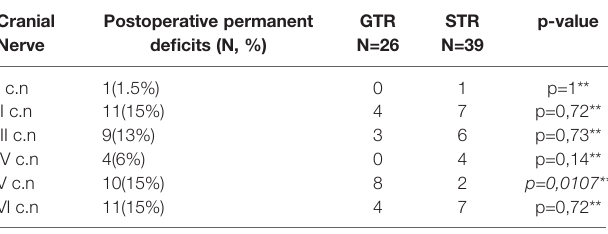
TABLE 3 | Postoperative cranial nerve de fi